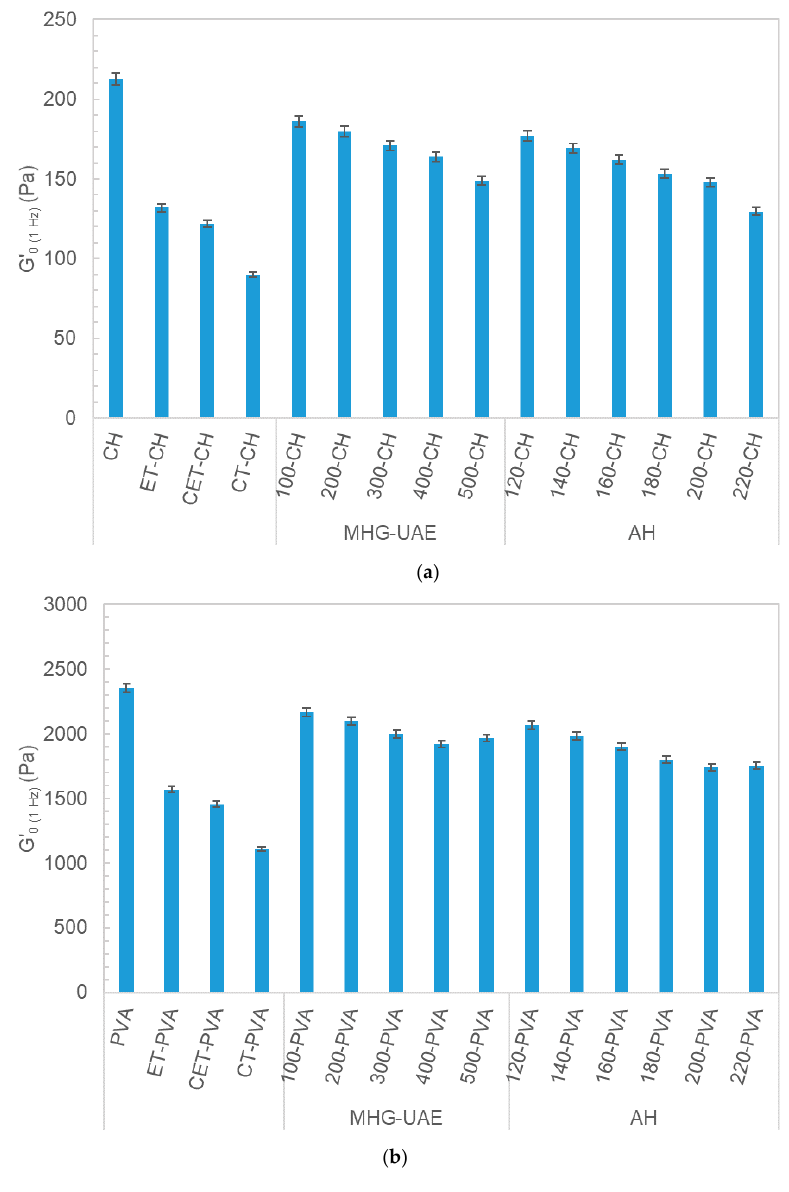
Figure 8. Impact of the processing treatments on the viscoelastic features of the gelled matrices formulated with chitosan (CH, ( a )) or polyvinyl alcohol (PVA, ( b )) incorporated with ethanolic arnica extracts (ET, CETs) and commercial tinctures (CTs) as well as with arnica extracts after the MHG-UAE stage at different powers or AH processing at tested final tem- peratures.